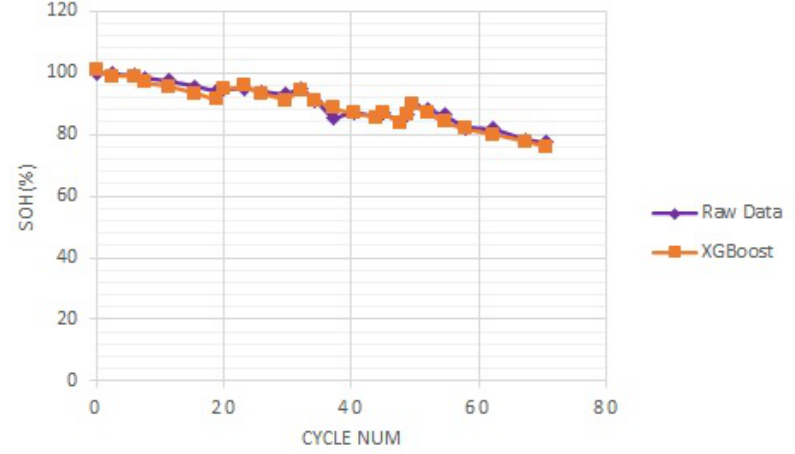
Figure 9. The prediction results on dataset 6 with extreme gradient boosting